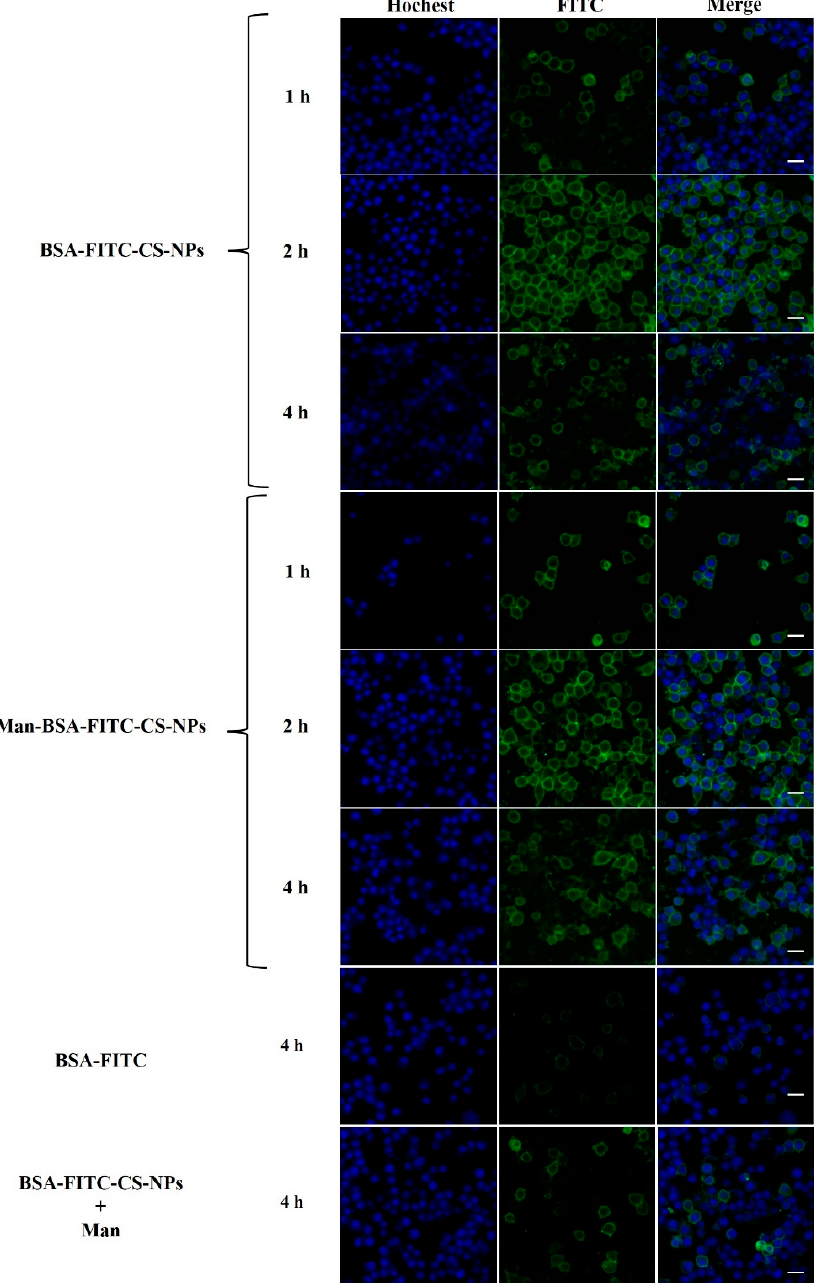
Figure 11. The cellular uptake of different formulations in DC2.4 cells at different time (1 h, 2 h, 4 h) observed by confocal microscope. Scale bar: 20 μ m.